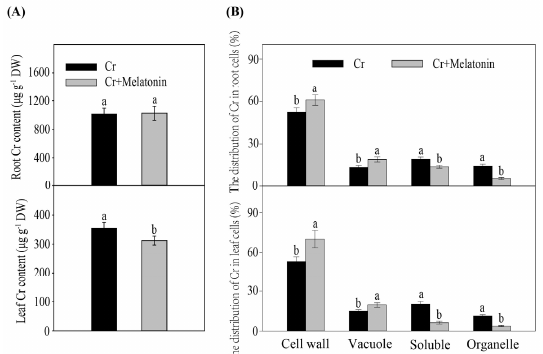
Figure 2. Effect of melatonin on Cr content ( A ) and its subcellular distribution ( B ) in maize roots and leaves during Cr stress. Different letters in one measure (cell wall, vacuole, soluble, or orga- nelle) denote significant differences at p < 0.05. Data are shown as mean ± SE ( n = 3). 2.3. Melatonin and Cr Treatments Induce Transcriptome Reprogramming in Maize To further clarify the possible mechanism of the alleviating effect of melatonin on Cr stress, transcriptome analysis was performed on the leaves and roots of maize in the Cr and Cr+Melatonin (50 μ M) treatments. A high correlation was observed between RNA-Sequencing and qRT-PCR data, confirming the accuracy of the transcriptome re- sults (Figure 3A,B). In the Cr vs. Control and Cr+Melatonin (50 μ M) vs. Cr comparisons, 4814 and 5765 differentially expressed genes (DEGs; |log 2 fold change| > 1) were identi- fied in roots, and 6272 and 5938 DEGs were identified in leaves, respectively (Figure 3C). Subsequently, we performed a Kyoto Encyclopedia of Genes and Genomes (KEGG) pathway enrichment analysis to identify the metabolic pathways potentially affected by melatonin during Cr stress (Figure 3D). These pathways were mainly related to starch and sucrose metabolism, cysteine and methionine metabolism, MAPK signaling, plant hormone signal transduction, glutathione metabolism, and ABC transports.